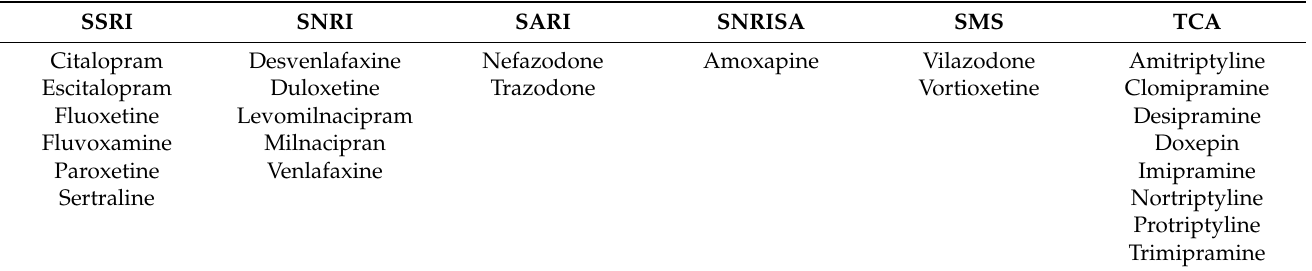
Table 2. Antidepressive agents with serotonin reuptake transporter (SERT) inhibition activity.